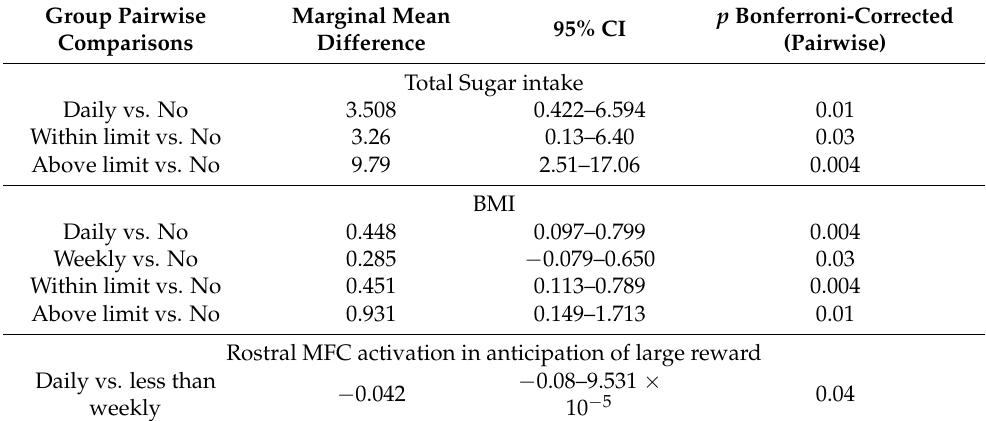
Table 3. Post hoc comparisons with Bonferroni correction for multiple